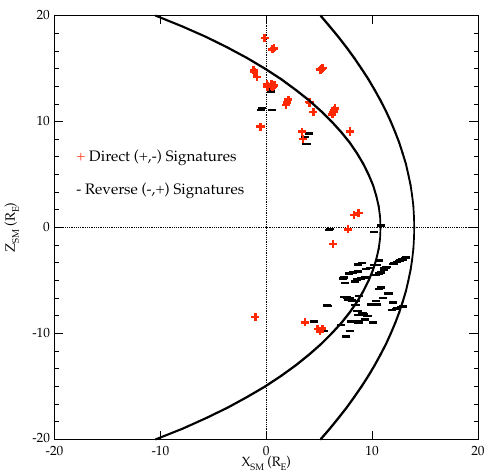
Fig. 9. The locations in the X-Z solar-magnetic (SM) plane of the 162 FTEs that Interball-1 observed from 1995 to 1999 within 10 R E of the X-Z plane. Direct events (red crosses) predominate north of the geomagnetic equator, reverse events (black dashes) predominate south of the equator, and a mixture of signatures occur in the vicin- ity of the geomagnetic equator.